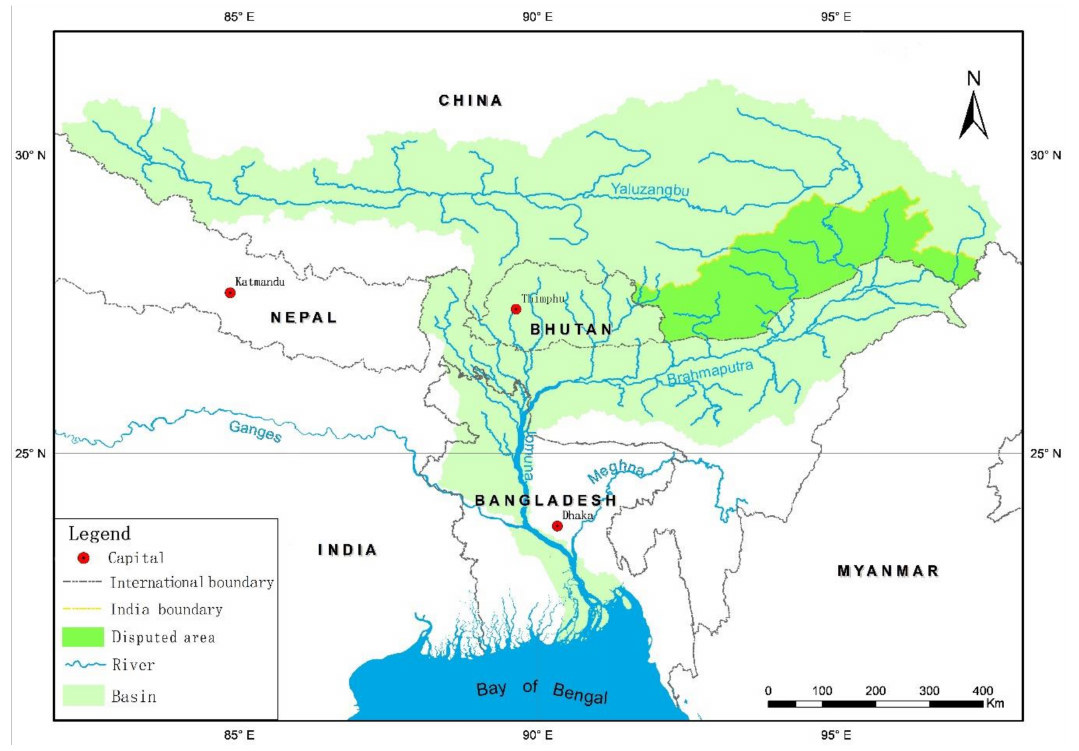
Figure 1. Map of the Yaluzangbu-Brahmaputra River